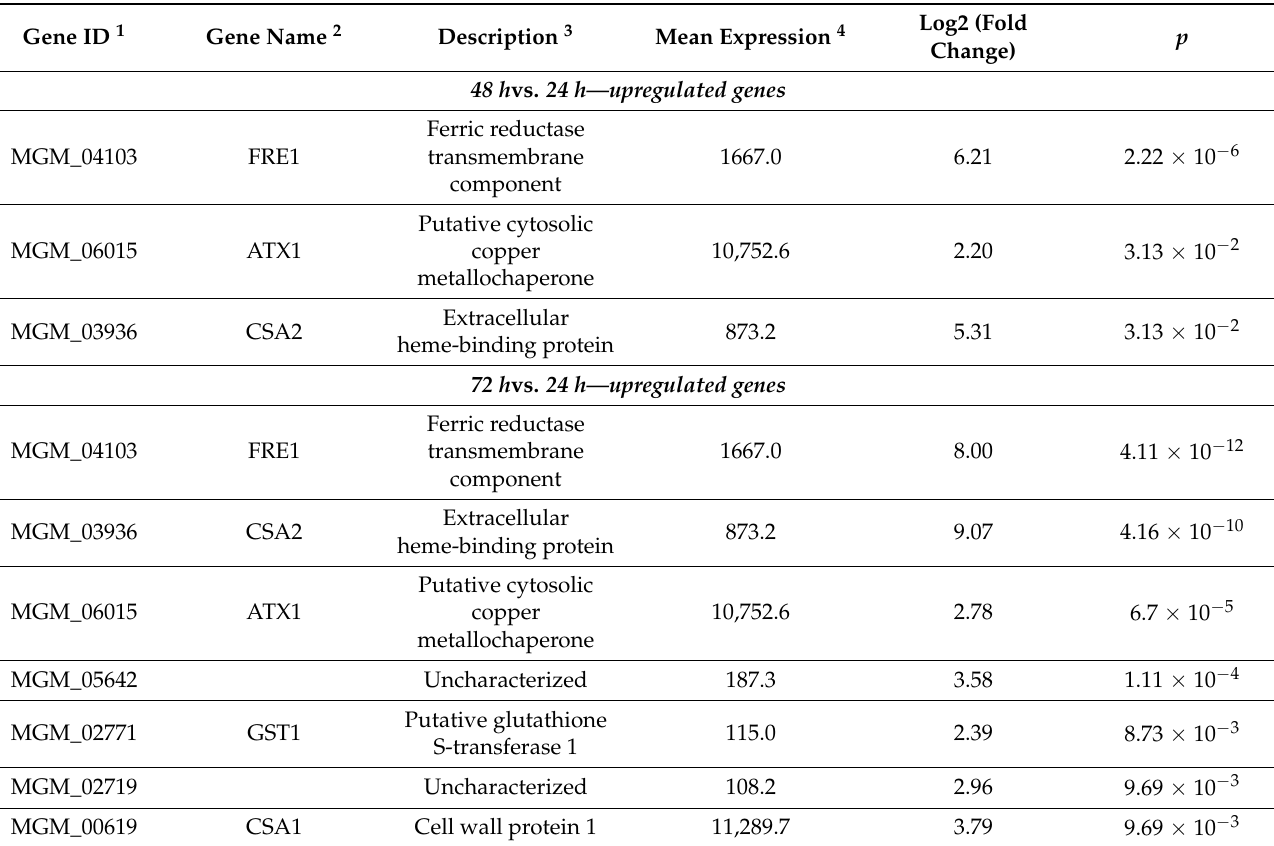
Table 2. Differential expression characteristics of seven genes selected from comparisons regarding times of incubation in Candida albicans isolates (CA1, CA2,